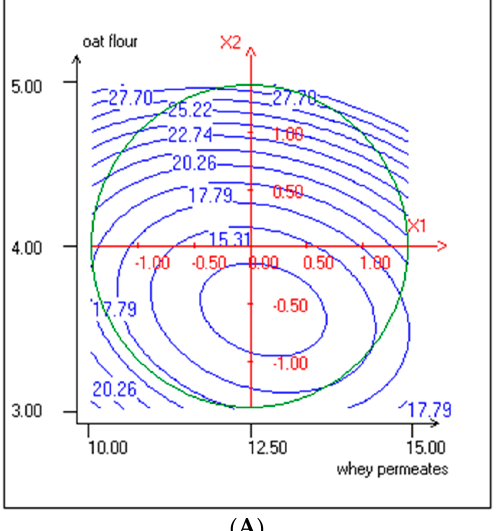
Figure 2. ( A ) Response surface and contour plots representing the effect of WP and OF on pH values (X1: WP; X2: OF). ( B ) Response surface and contour plots representing the effect of WP and OF on TTA (X1: WP; X2: OF).